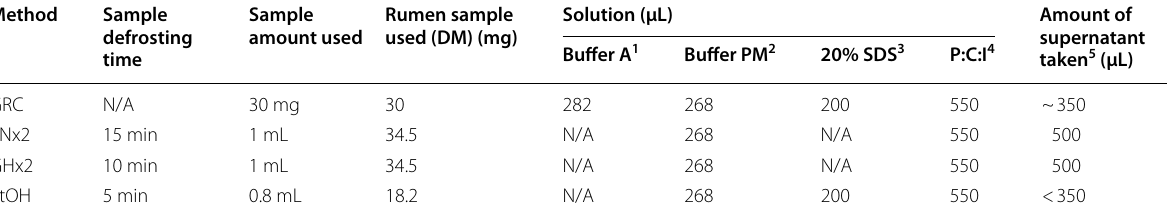
N/A denotes not applicable, and DM denotes dry matter